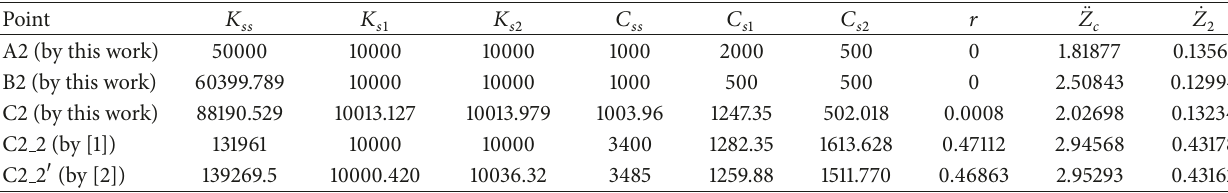
Table 6: Objective function values and trade-off design variables of [1, 2] and this work shown in Figure 15. Point